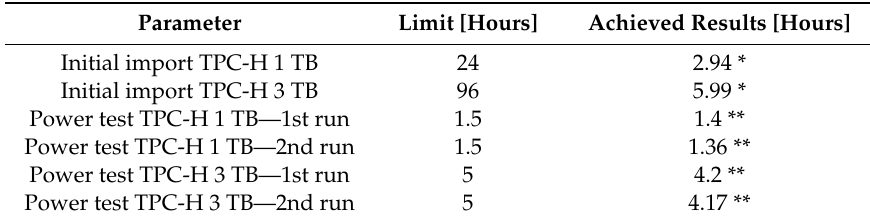
Table 1. TPC-H parameters for database (sizes 1 TB and 3 TB) and limiting values for power tests in the first and second runs, provided by